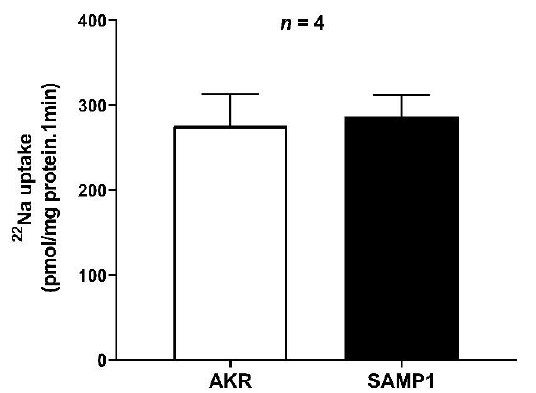
Figure 4. Na/H exchanger (NHE3) activity in ileal villus cells BBMV. pH dependent and amiloride sensitive 22 Na uptake was measured as NHE3 activity, which remained unchanged in BBMVs of intestinal villus cells from SAMP1 mice compared with AKR control mice.